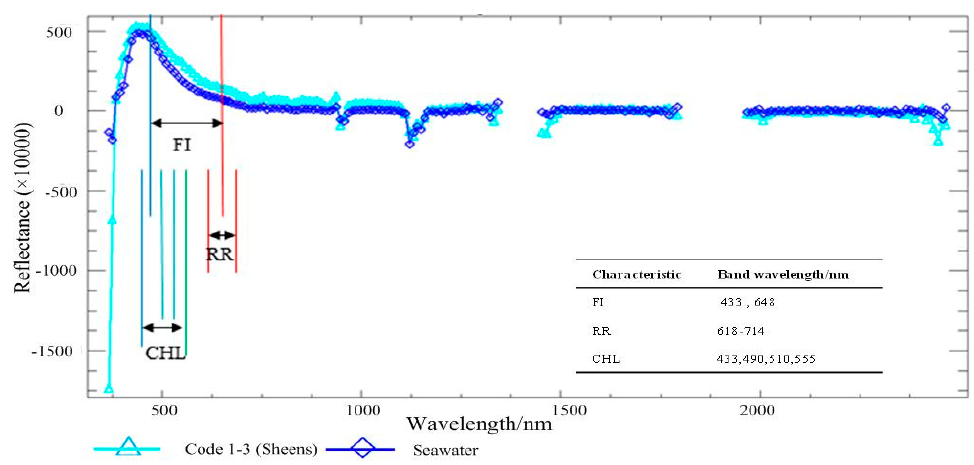
Figure 11. Spectral curve analysis for identifying sheens (cyan) and seawater (blue) by FI, RR, and CHL.